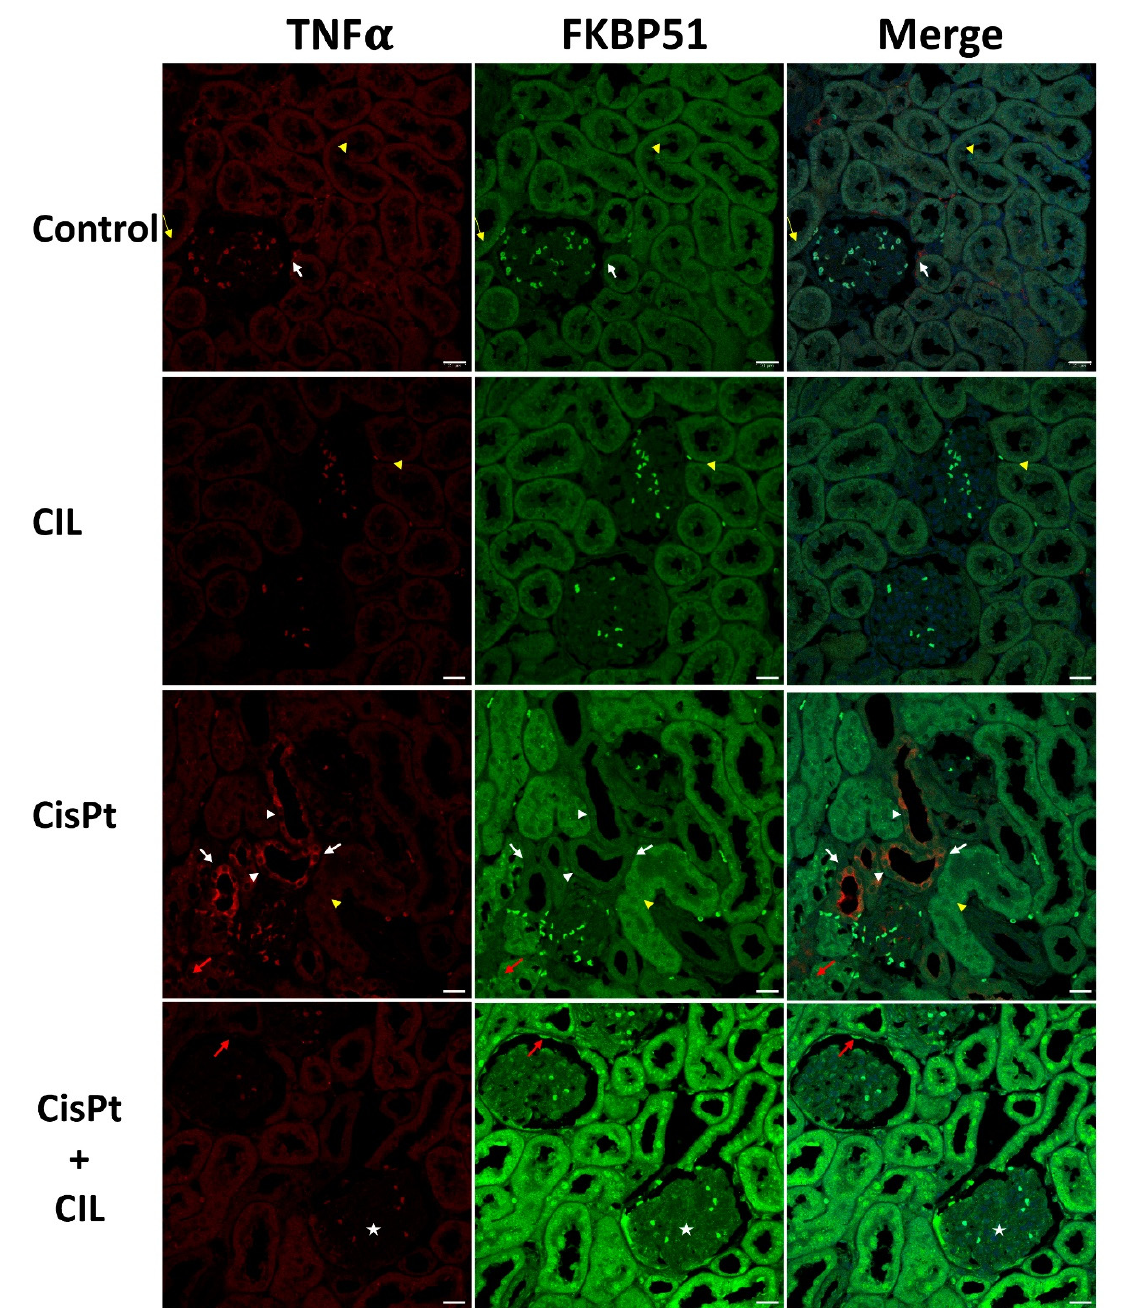
Figure 4. Expression of FKBP51 in cisplatin-treated and cilastatin-protected rat kidney. Control panels: tubular cells show low immunostaining of TNF α and FKBP51 in cytosol. White arrows point to small areas of higher TNF α fluorescence in the outer glomerular capsule cells, yellow thin arrows point to more intense FKBP51 fluorescence around nuclei in some tubule cells and yellow arrowheads point to some physiological cell blebbing. CIL panels: kidney tubule cells of cilastatin-treated rats show TNF α and FKBP51 immunostaining very similar to controls in localization and intensity. Yellow arrowheads point to some physiological cell blebbing. CisPt panels: kidney tubule cells of cisplatin- treated rats: TNF α -specific immunofluorescence appears heterogeneous within the same tubules, with several cells showing high levels in the cytosol (white arrows), while in some other cells the cytosolic signal is fainter (white arrowheads). Most tubules show a low-level signal, though slightly brighter than controls. Some tubules, such as the one indicated by the yellow arrowhead, present abundant cell blebbing. FKBP51-specific immunofluorescence presents two intensity levels: a